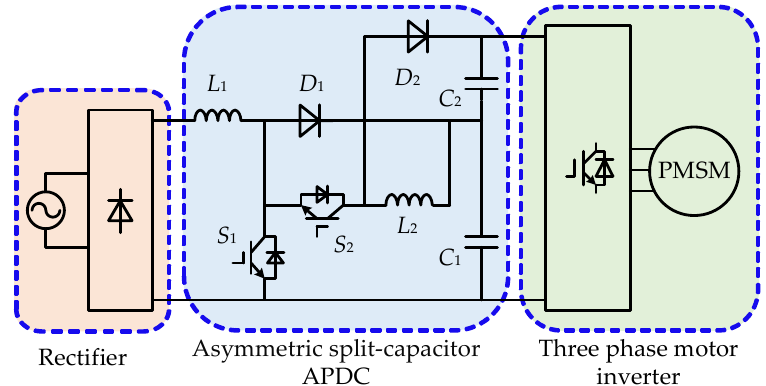
Figure 1. The ECL drive system based on asymmetric split-capacitor APDC. Figure 2 shows the four operation modes of asymmetric split-capacitor APDC in one operation cycle. S 1 and S 2 are respectively used to control the grid power quality and to suppress DC-link voltage ripple. When S 1 is on-state, L 1 stores the grid ripple power, and the current of L 1 increases. When S 1 is off, the grid and L 1 in series supply power to the back-end converter, and the current of L 1 decreases. Therefore, the grid current quality can be controlled by S 1 . Meanwhile, the average voltage of C 1 can be controlled. When S 2 is on, C 1 charges L 2, and the voltage of C 1 decreases. When S 2 is off, L 2 supplies power to C 2 . Therefore, the voltage of C 2 can be controlled by S 2 . Finally, the voltages of C 1 and C 2 are complementary, and the DC-link voltage ripple can be suppressed by S 1 and S 2 .